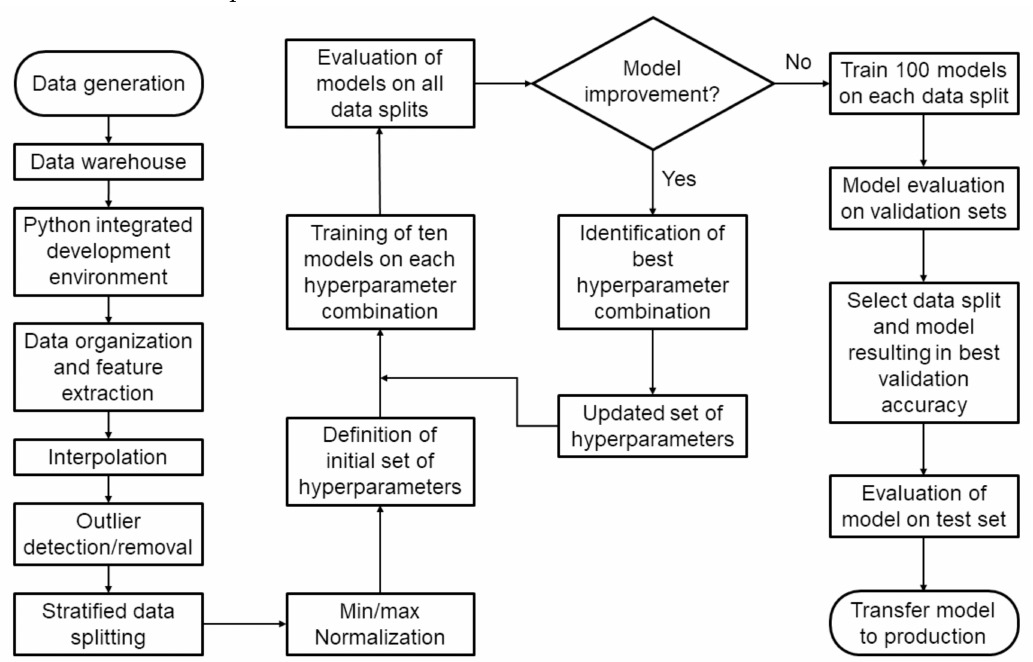
Figure 1. Flowchart of the data processing and model development